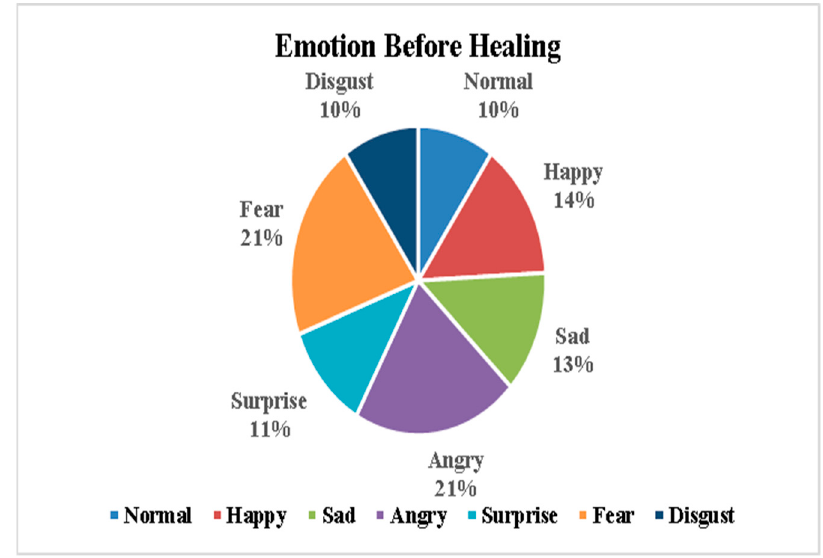
Figure 12. Participants’ emotions before healing.